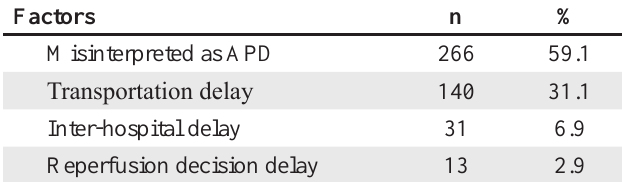
Table 4: Factors causing pre-hospital delay (n=450)